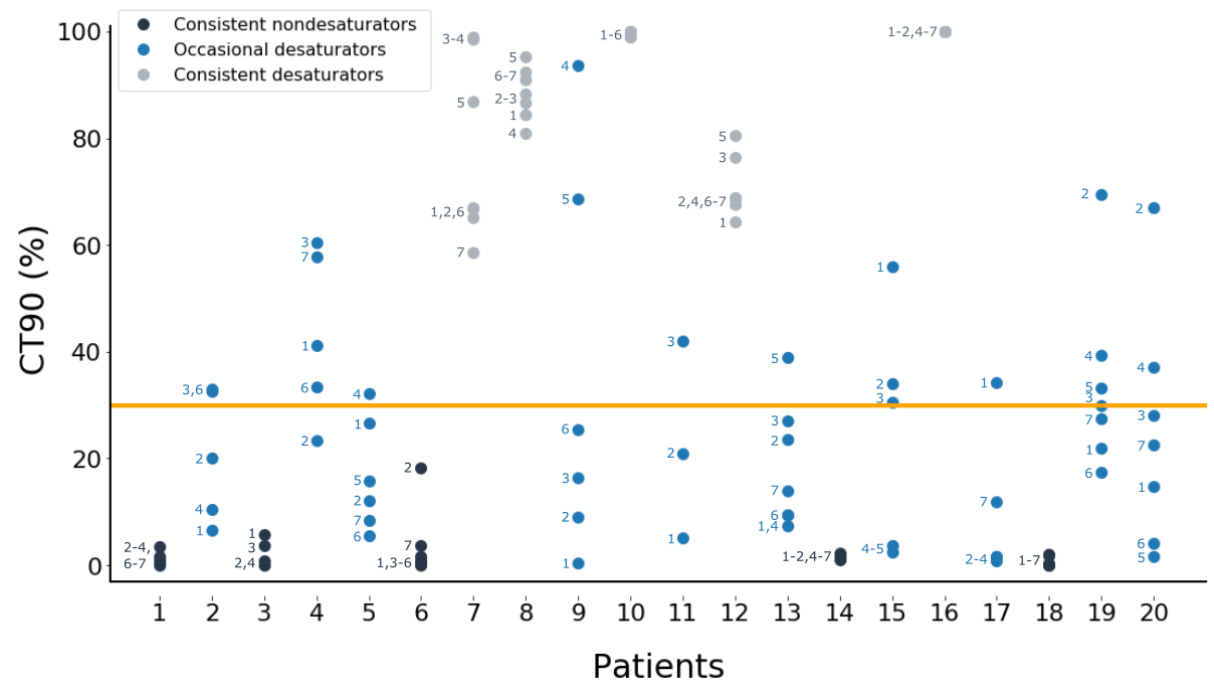
Figure 5. Cumulative time spent with peripheral blood oxygen saturation (SpO 2 ) below 90% (CT90) values for every night of every patient showed that 50% (10/20) of the included patients changed category between desaturator and nondesaturator. The number next to each dot indicates the corresponding night of the measuring week and the orange line indicates the threshold of CT90 (30%) that divides nights with and without desaturation. A missing night number indicates that no data was available for that